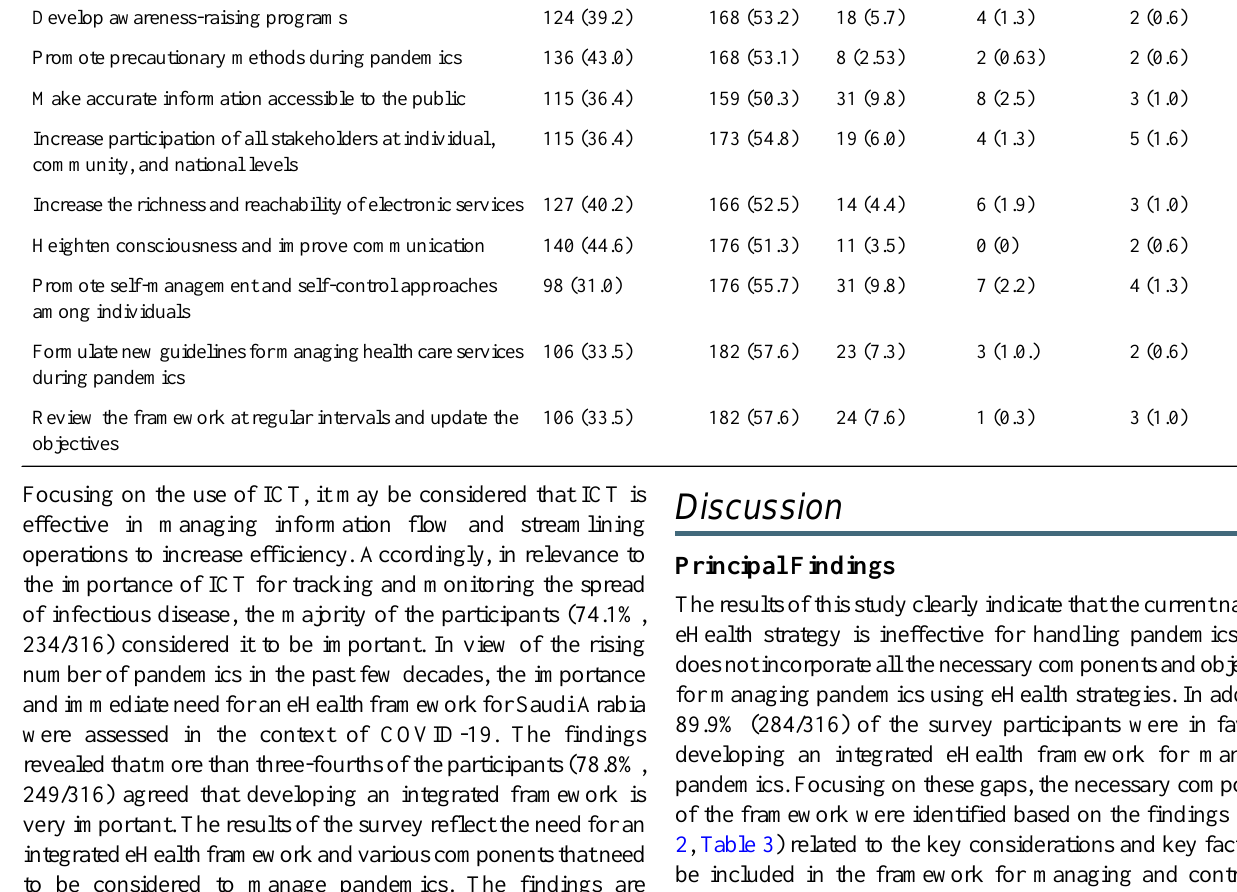
Strongly disagreeDisagreeNeutralAgreeStrongly